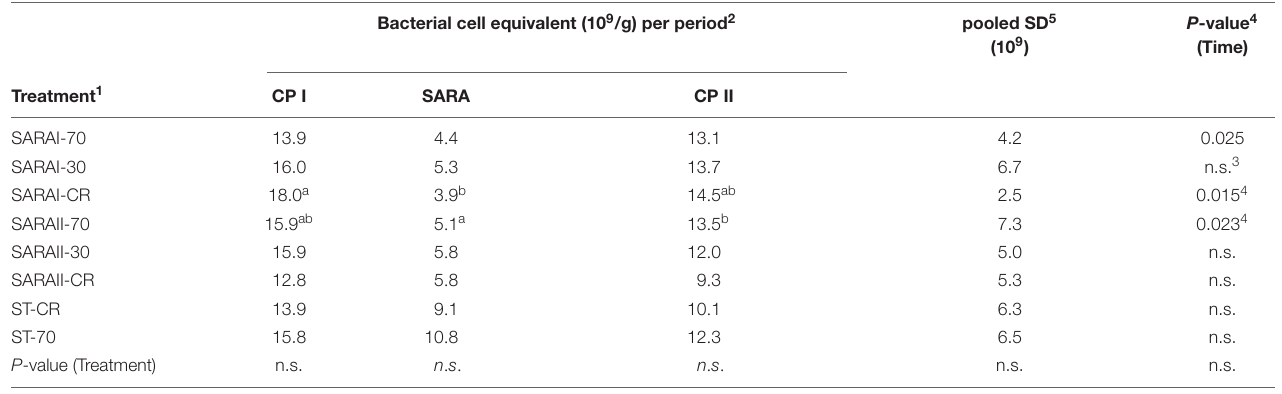
TABLE 1 | Mean copy numbers of the bacterial 16S rRNA gene in solid samples. Bacterial cell equivalent (10 9 /g) per period